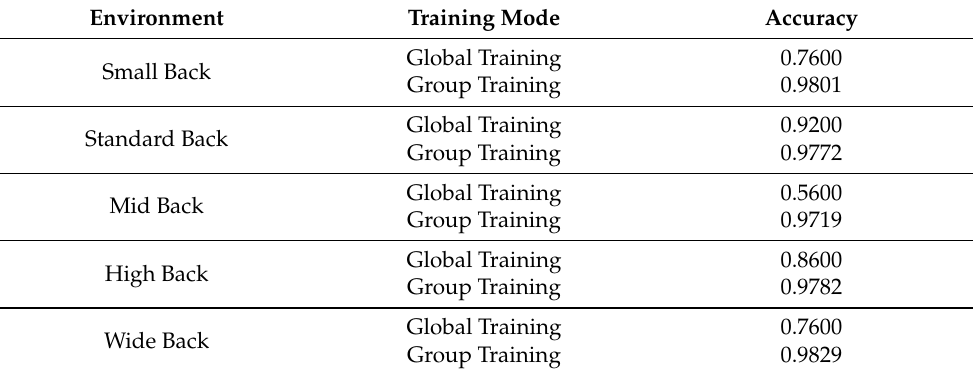
Table 5. Accuracy of the best-performing machine learning classifier (Random Forest) in the posture recognition task in five different environments using two modes of